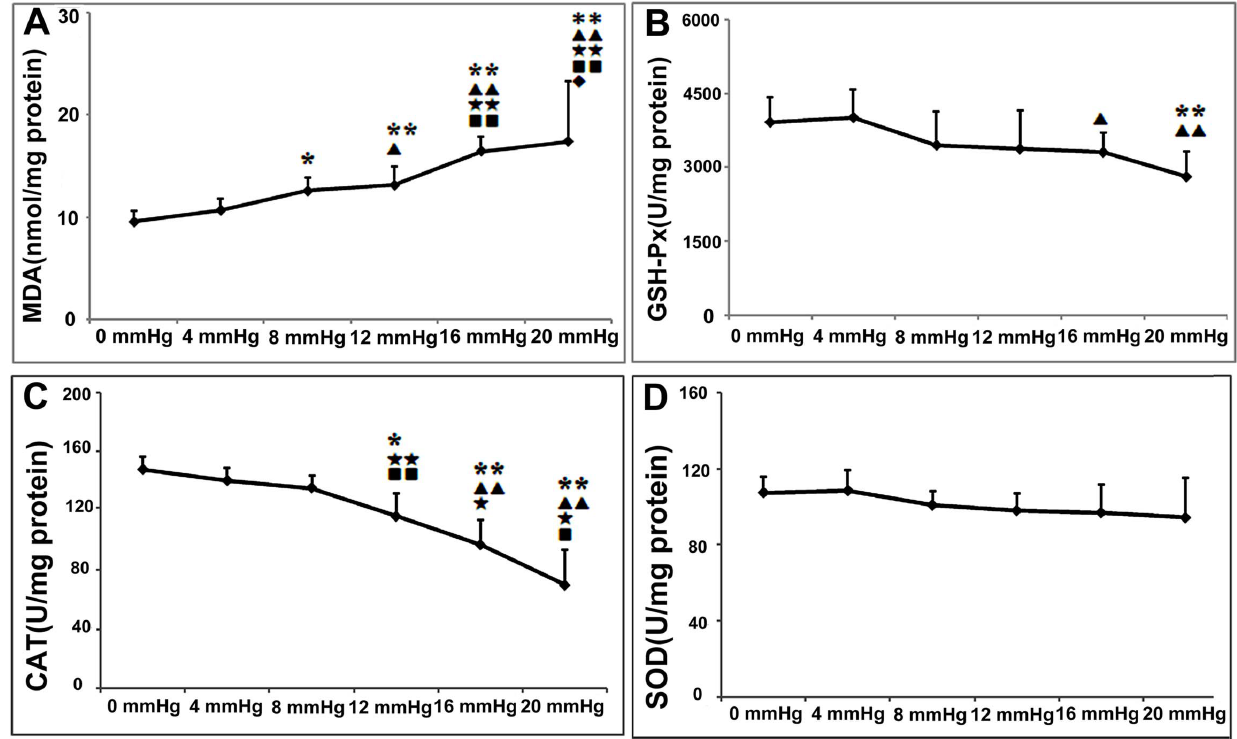
Figure 2. The effects of the different grades of nitrogen pneumoperitoneum on colonic pro-oxidant-antioxidant balance. A: Malondialdehyde (MDA), the product of lipid peroxidation. B–D: The antioxidant enzymes of glutathione peroxidase (GSH-Px), catalase (CAT), and superoxide dismutase (SOD). At 4 mmHg, the pro-oxidant-antioxidant balance was stable, and no significant differences in related parameters were detected between the 0- and 4-mmHg groups. Intra-abdominal pressures of $ 8 mmHg showed adverse effects on colonic pro-oxidant-antioxidant balance. Compared with that in the 0-mmHg group, the MDA concentrations in the 8, 12, 16, and 20-mmHg groups were significantly higher, whereas the CAT and GSH-Px concentrations tended to decline. No obvious changes in the SOD levels were detected. All data are shown as means 6 SD. *P , 0.05, **P , 0.01, vs. 0 mmHg; m P , 0.05, mm P , 0.01, vs. 4 mmHg; w P , 0.05, ww P , 0.01, vs. 8 mmHg. & P , 0.05, && P , 0.01, vs. 12 mmHg, X P , 0.05, vs. 16